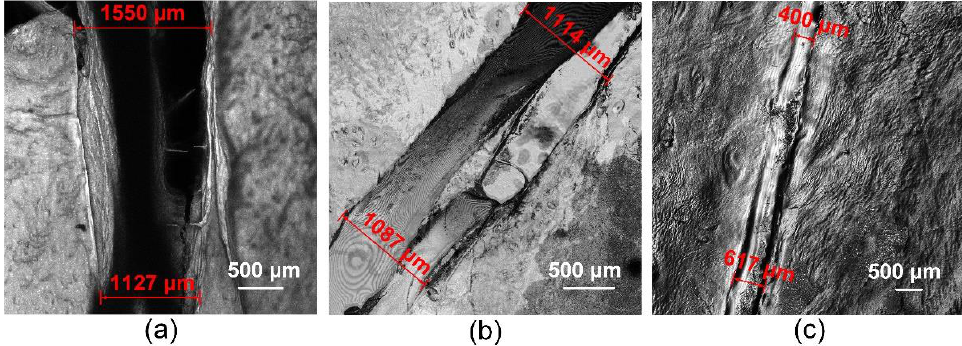
Figure 5. Laser scanning Microscopy images of a traditional suture ( a ) and laser welds with solder based on BSA+ICG (group 2) ( b ), BSA+ICG+SWCNT (group 4) ( c ).